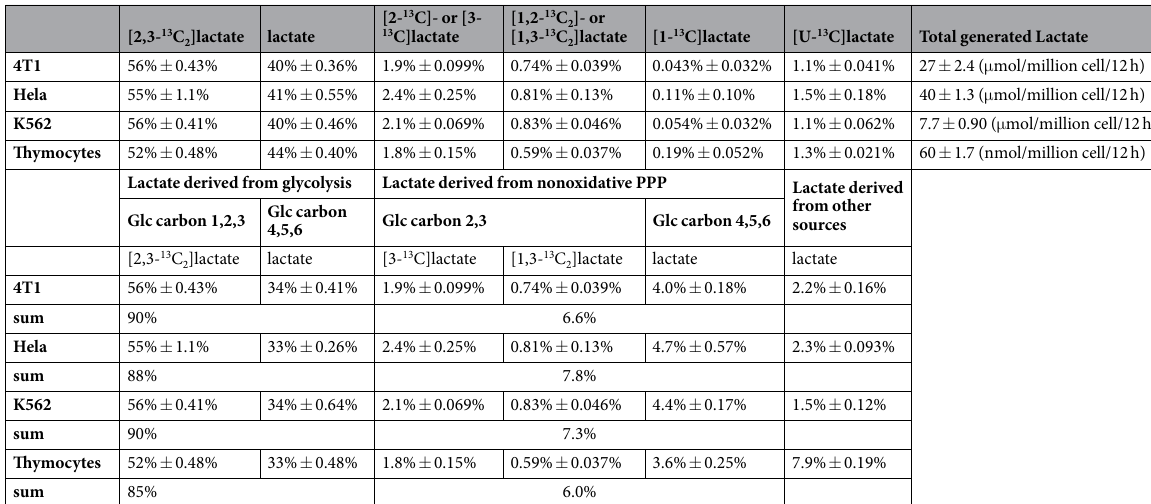
Table 2. The percentage of lactate isotopomers and isotopologues (mean ± SD, n = 12) generated by 4T1, Hela, K562, and thymocytes, traced by [1,2- 13 C 2 ]glucose (upper part), the percentage of lactate (mean ± SD, n = 12) derived from glycolysis, PPP and other sources (down part). 4T1, Hela, K562 and thymocyte were incubated in serum-free RPMI-1640 medium containing 6 mM [1,2- 13 C 2 ]glucose for 12 hours in a humidified CO 2 incubator and culture supernatant was collected for LC-MS/MS analysis as described in Materials and Methods. The upper part summarizes the percentage of all lactate isotopologues. The down part assigned the percentage of isotopologues that are generated from glycolysis, pentose phosphate pathway (calculated based on percentage of [3- 13 C]- and [1,3- 13 C 2 ]lactate as described in corresponding text), and other sources (according to percentage listed in Table 1). Data are mean ± SD, n = 12, from 2 independent